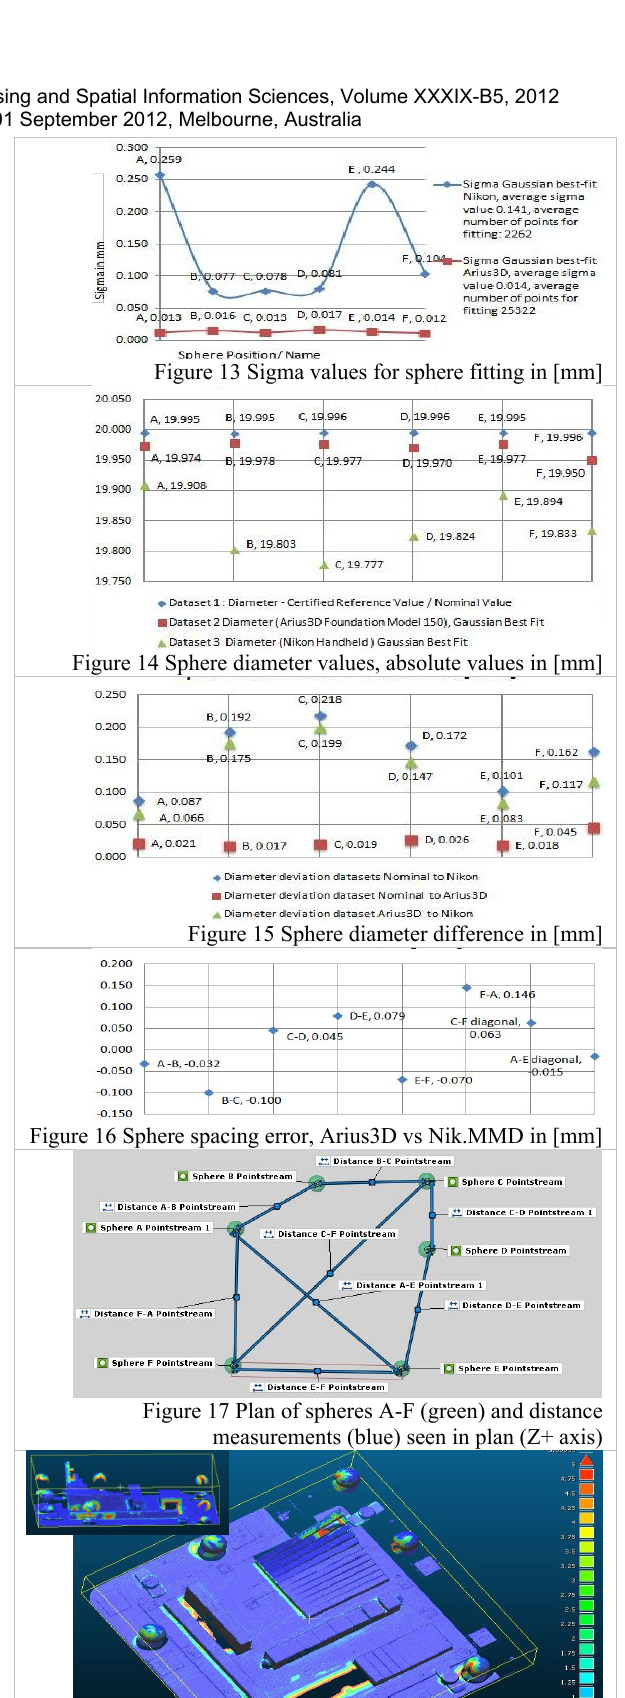
Figure 13 Sigma values for sphere fitting in [mm]